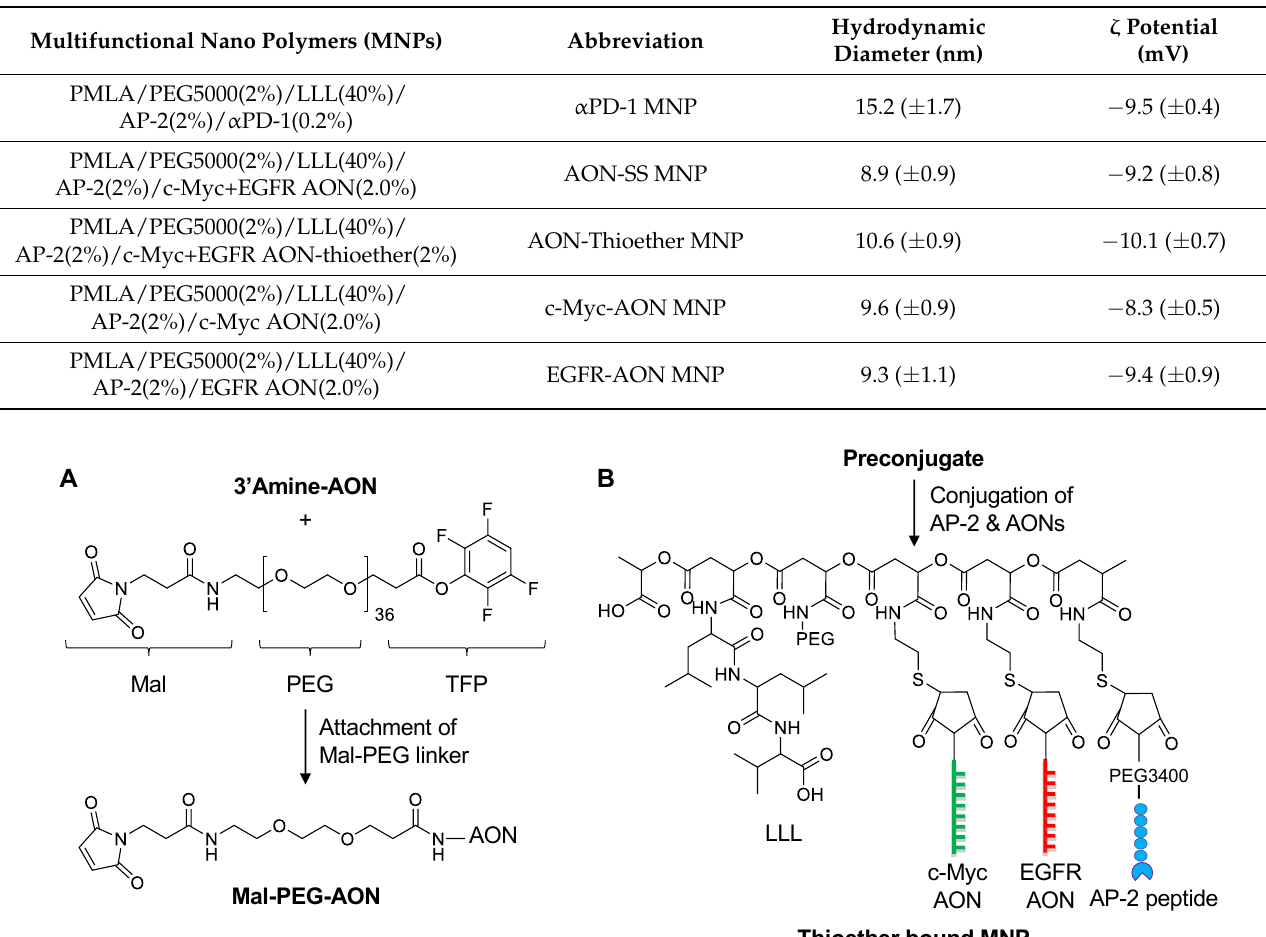
Figure 3. Synthesis of MNP carrying thioether-bound (direct) AONs to target c-Myc and EGFR . We used a thioether bond (direct conjugation) to attach AONs. The term “direct AON” was used to simplify AON attachment, differing from S-S-bound traditional synthesis, yielding cleavable AONs. ( A ) Synthesis of Mal-PEG-AON; ( B ) synthesis of full “direct AON”